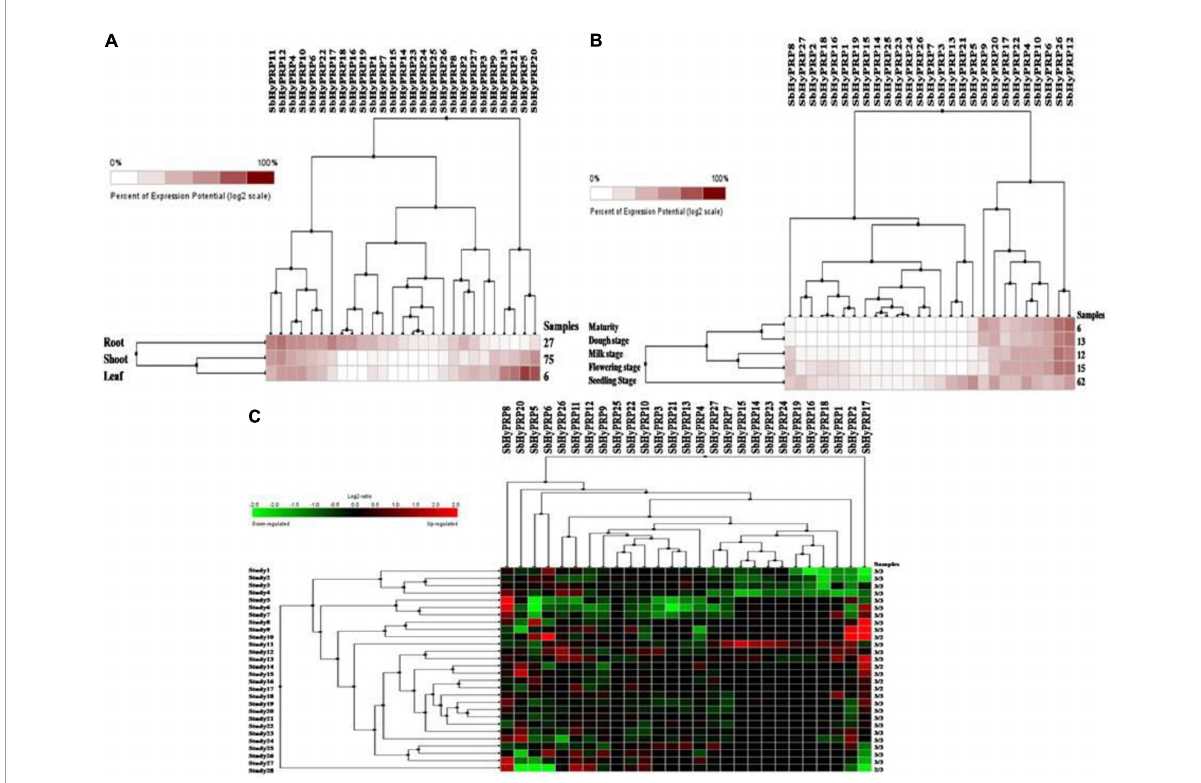
FIGURE7 Digital expression profile of SbHyPRP genes in different organs, developmental stages under cold and drought stresses. (A) SbHyPRP in anatomical tissues, (B) SbHyPRP in developmental stages, (C) SbHyPRP gene expressions under cold and drought stresses.